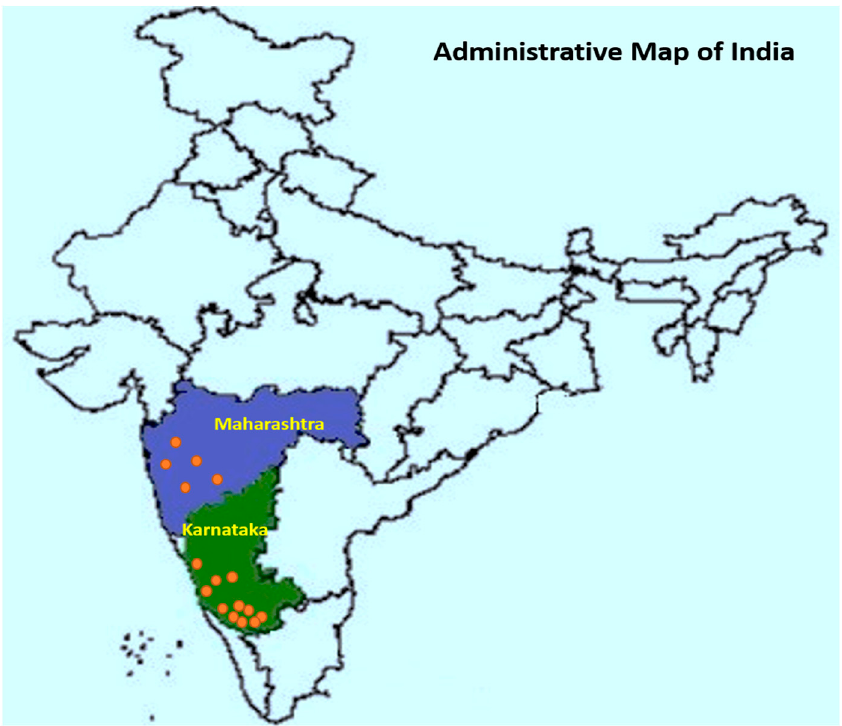
Figure 1. Location map of field trials conducted during the six growing seasons from 2012 to 2019 across the main Indian arecanut growing regions. Table 1. Information about the evaluated treatments against fruit rot disease (FRD) with multi-en- vironment profiles.